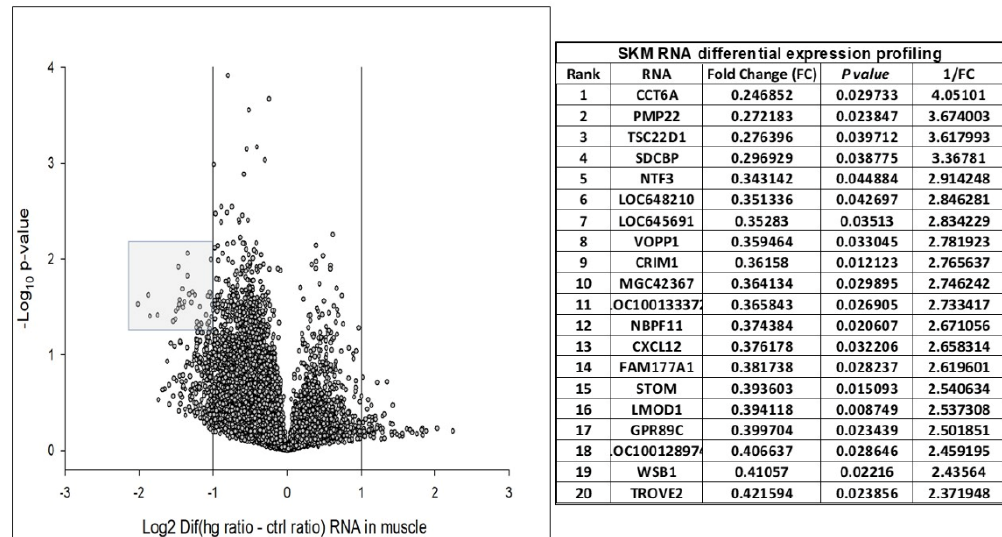
Figure 6. Twenty logarithmic fold change (FC) > 2 and significant p -values for skeletal muscle (SKM) differentially expressed genes (DEGs). Volcano plot of FC differences of SKM RNA expression between RG and CG. The vertical lines correspond to FC > 2.